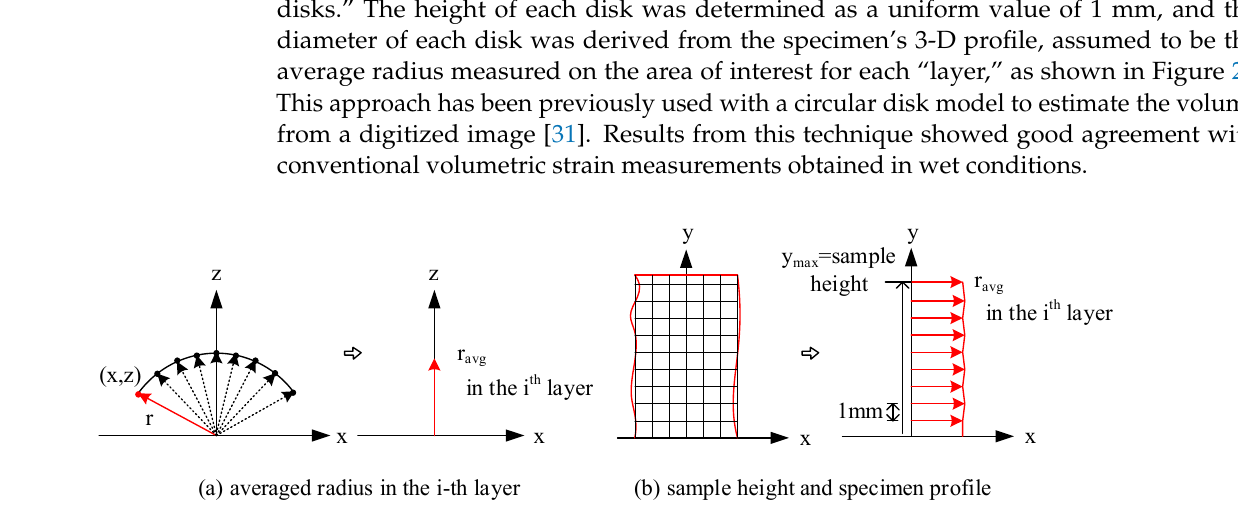
disks represents the bulk volume of the specimen at the current experimental stage.